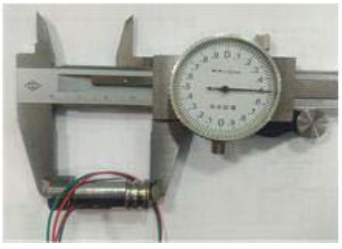
Figure 7. Miniature digital valve.